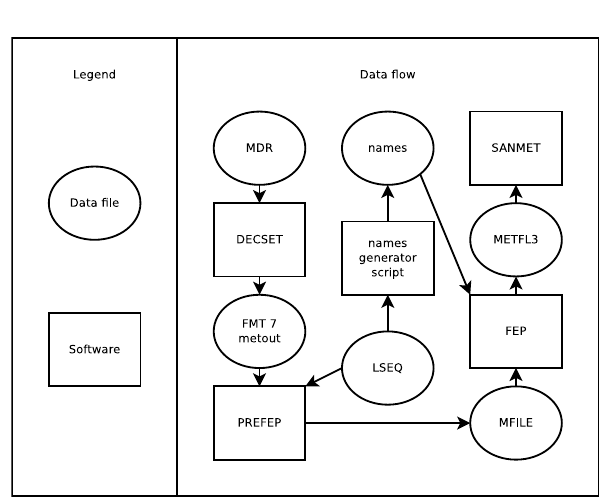
Fig. 1. Flow chart of the analysis package. The explanations of the abbreviations are explained in Sect.